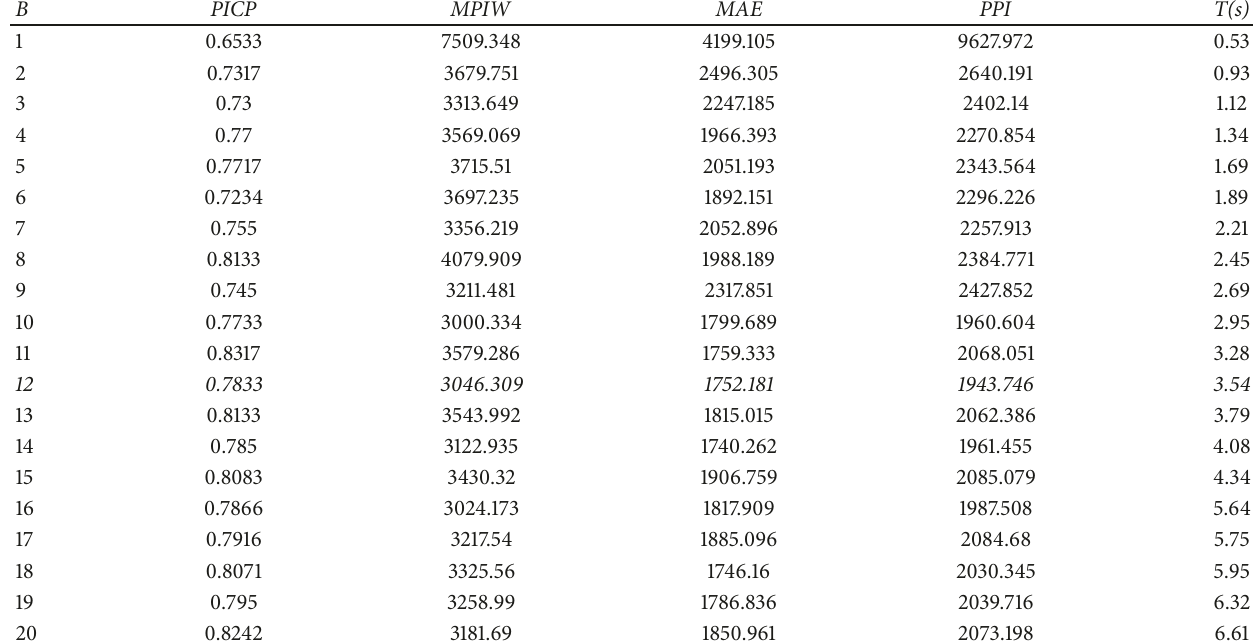
Figure 8: Prediction results for noisy Mackey Glass problem: (a) the constructed PIs; (b) the corresponding predicted error. Table 3: The validation result of the number of local